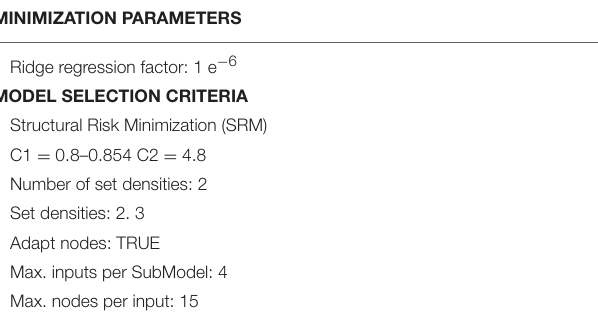
TABLE 2 | The training parameters setting with FormRules